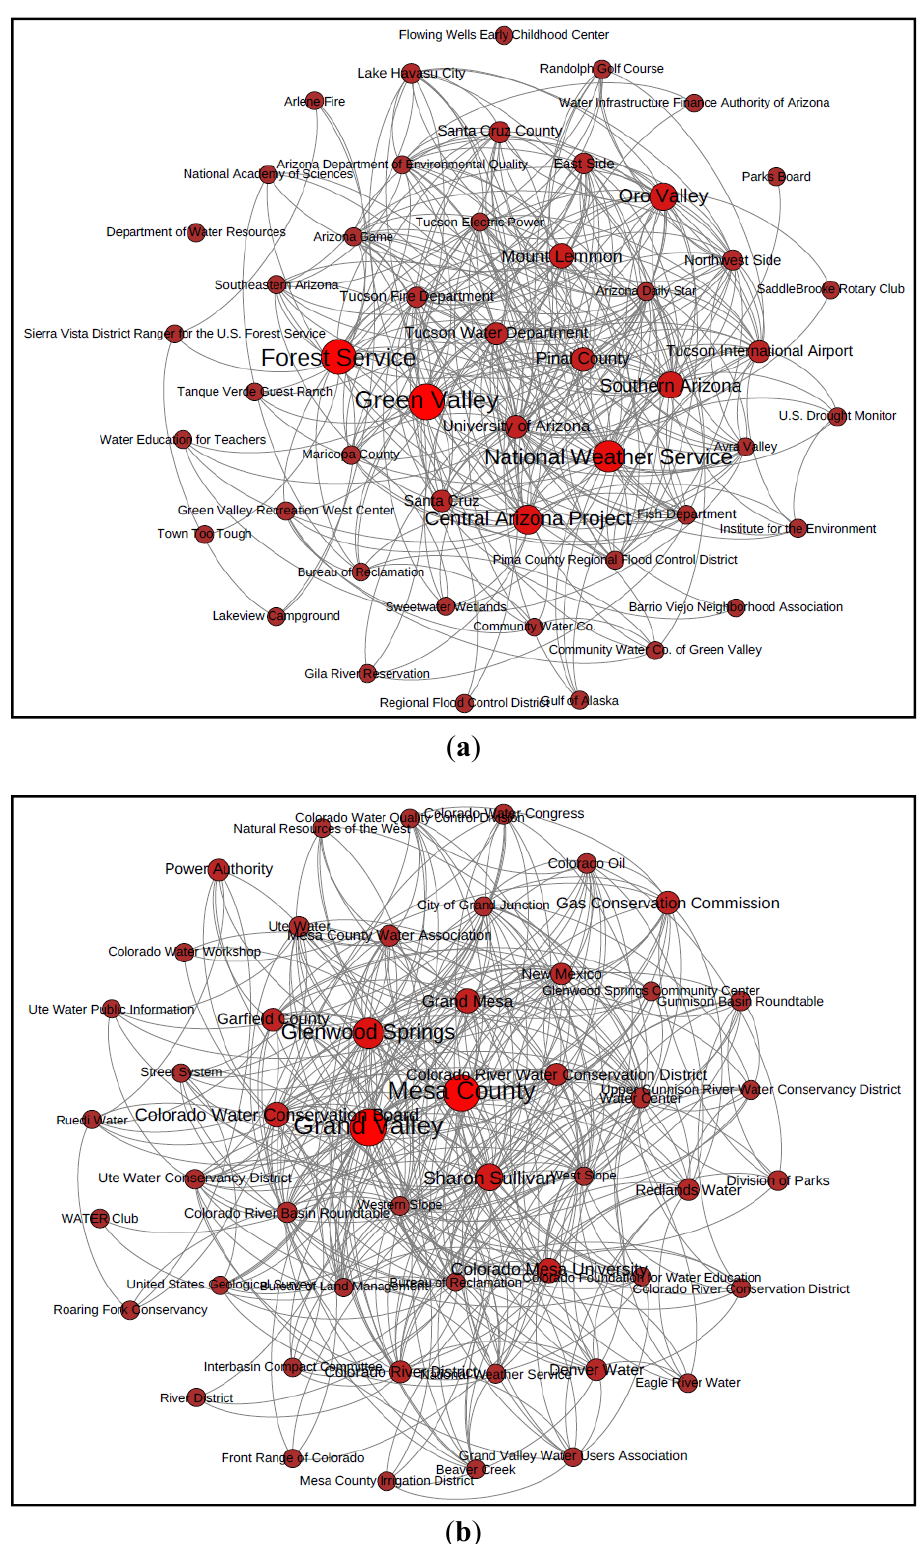
Figure 3. Networks generated from Step 1. ( a ) Tucson; ( b ) The Grand Valley; ( c ) Flagstaff; ( d ) Las